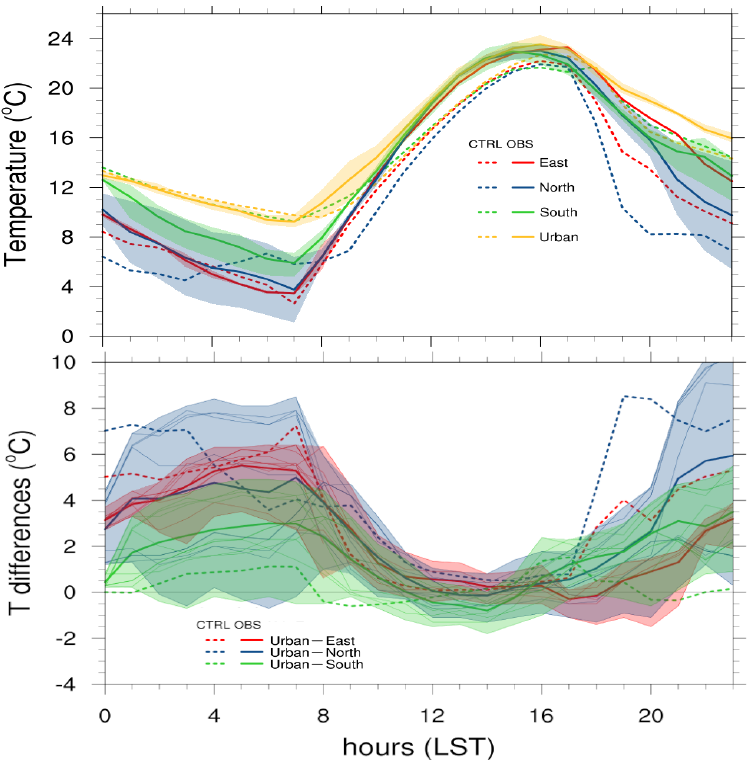
Figure 3. Diurnal cycle of temperature ( ◦ C) (upper panel) and UHI intensity ( ◦ C) (lower panel) for 10 February 2017. Full lines represent observations while dotted lines represent the CTRL model simulations. Upper panel shows the comparison between the observations and the model at four areas: East, North, South, and Urban as defined in the text. Lower panel shows the UHI intensity as the temperature differences between the Urban area and the other three areas. The shading corresponds to the spatial variability from stations within each